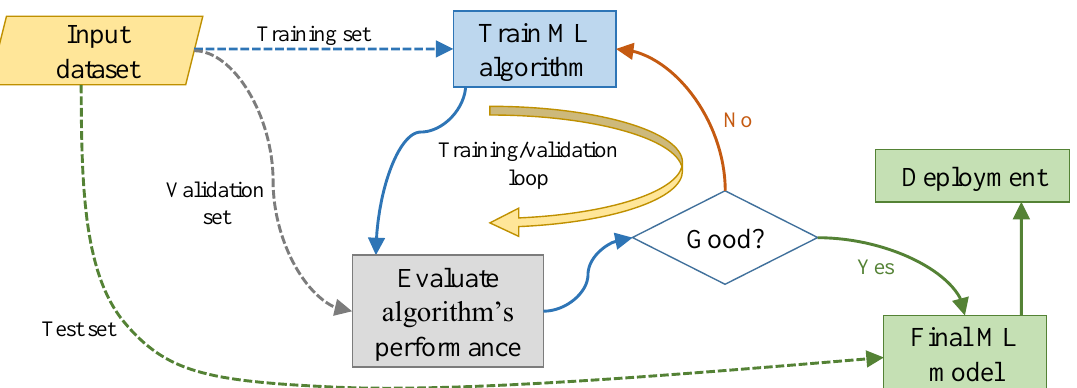
Figure 1. General workflow of a typical machine learning application.